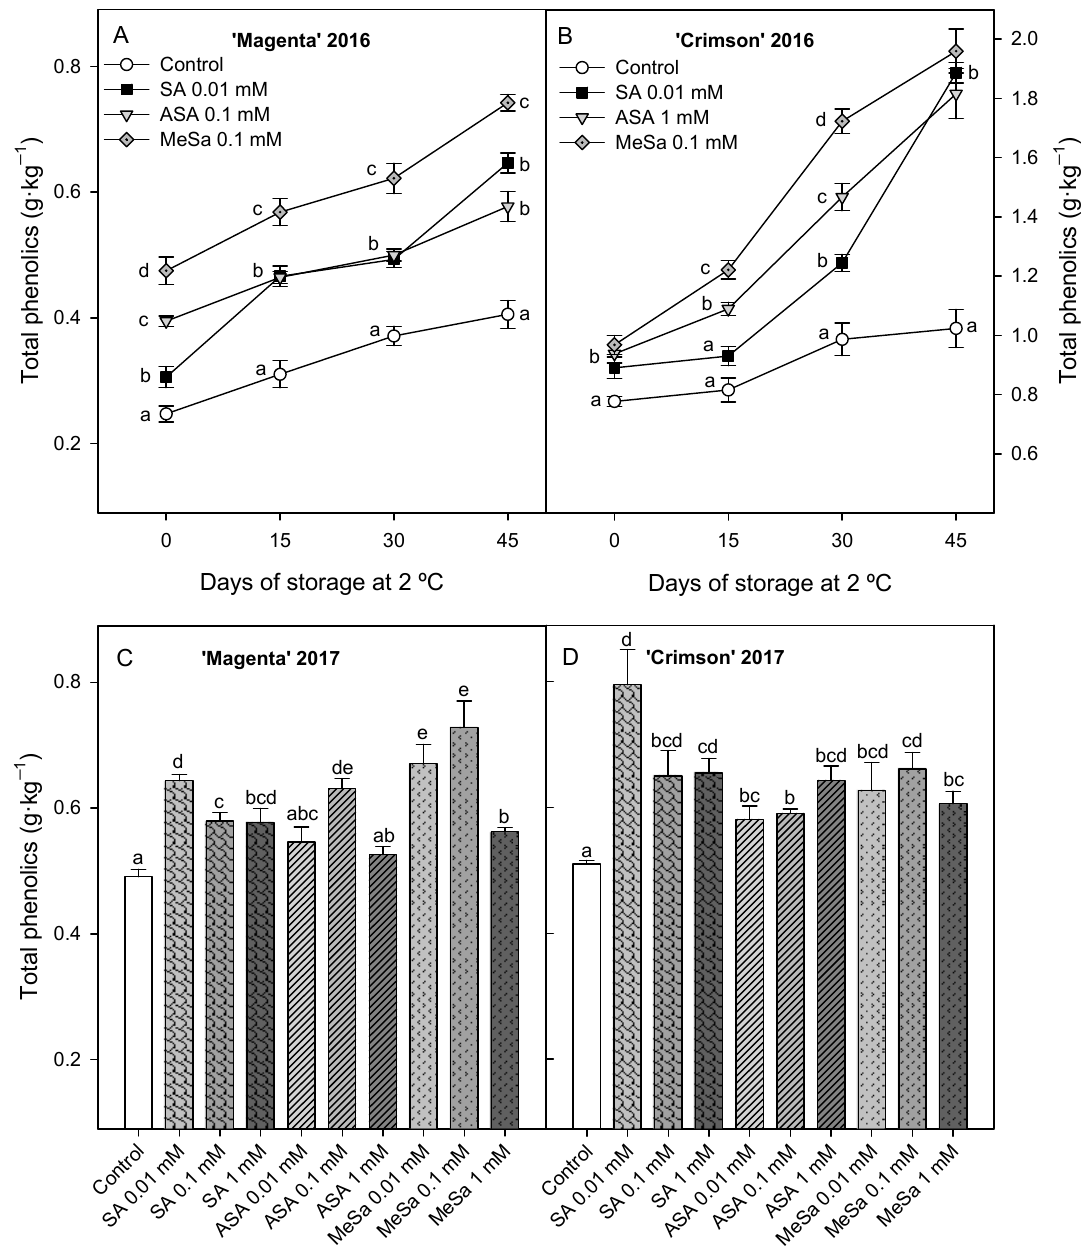
Figure 4. Total phenolic concentration at harvest and during storage at 2 ◦ C in 2016 experiment ( A , B ) and at harvest in 2017 experiment ( C , D ) in control and salicylic acid (SA), acetyl salicylic acid (ASA) and methyl salicylate (MeSa) treated berries of ‘Magenta’ and ‘Crimson’ cultivars. Data are the mean ± SE of quantifications made in duplicate in three replicates. Di ff erent letters show significant di ff erences ( p < 0.05) among treatments for each sampling